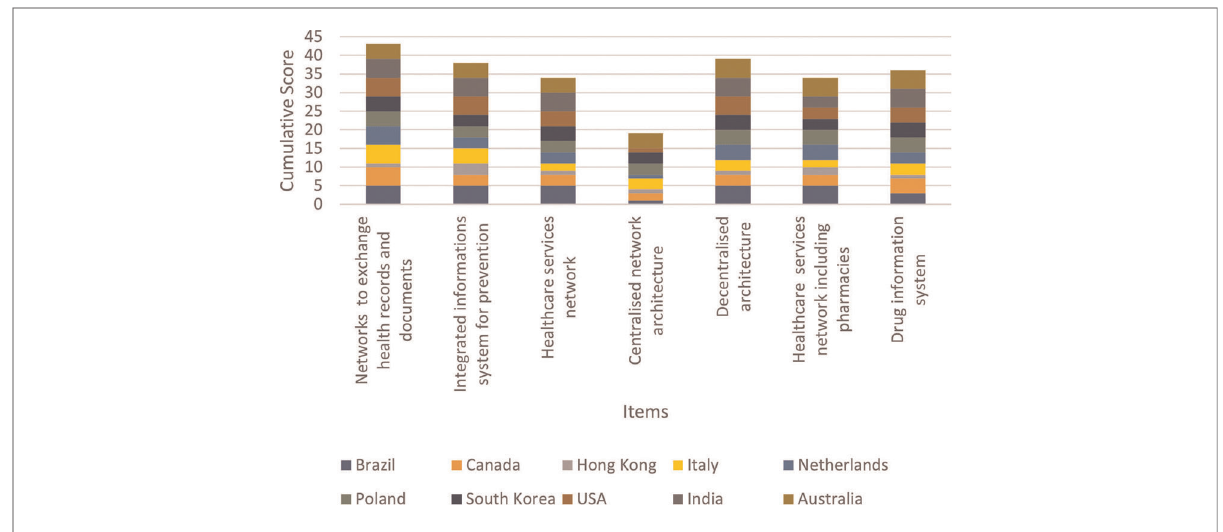
FIGURE 4 Cumulative score per proposed item of Topic 2.